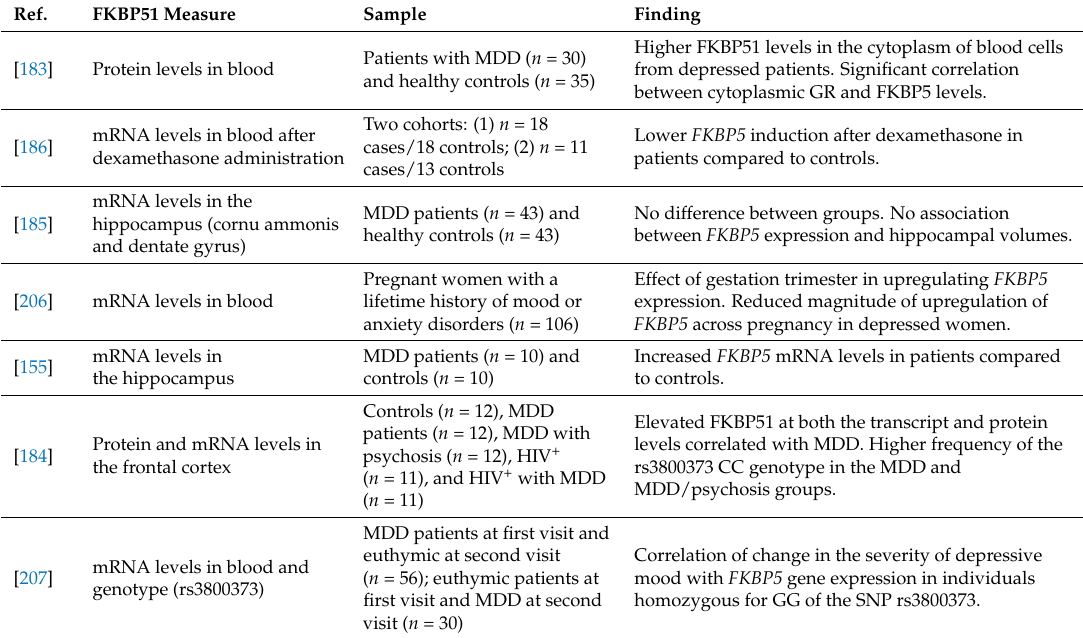
Table 2. Studies investigating the association between FKBP51 and